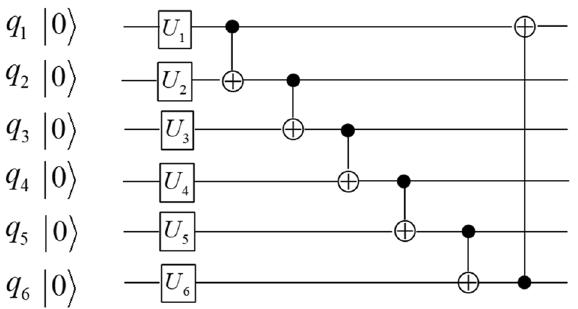
Figure 2. The quantum circuit of one layer of the hardware-efficient ansatz in Ref. 45